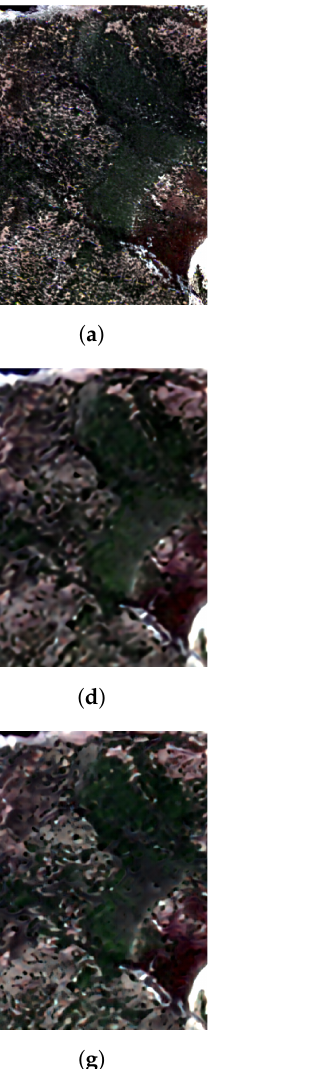
Figure 11. Results of a region of Cabrera from the W-S Set2. ( a ) HR, ( b ) LR with NN interpolation, ( c ) LR with bicubic interpolation, ( d) SR with α = 0, ( e ) SR with α = 0.1, ( f ) SR with α = 0.2, ( g ) SR with α = 0.5, ( h ) SR with α = 0.7, ( i ) SR with α = 1. Image size: 378 × 256